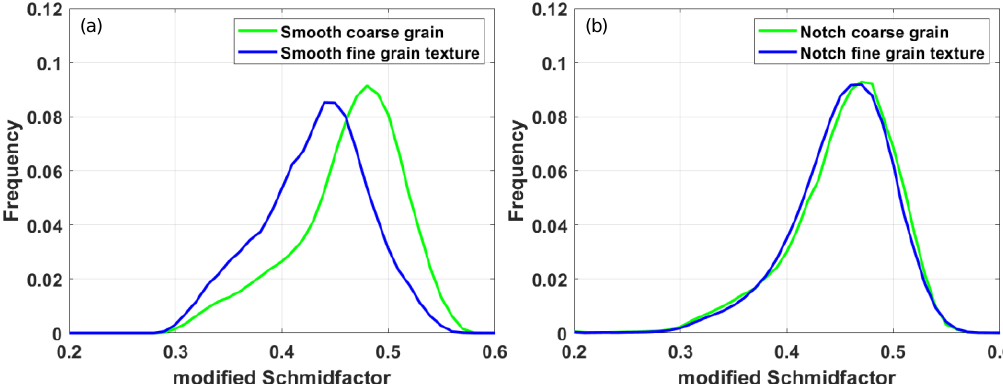
Figure 20. Distribution of modified Schmid factor for random-orientated coarse-grain and fine-grain textured smooth ( a ) (according to [17]) and notched specimen ( b ).